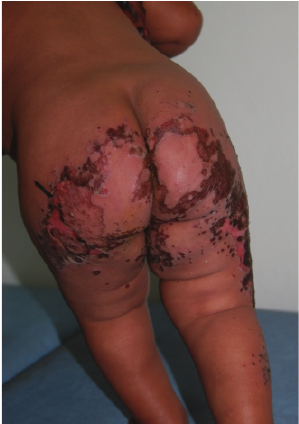
Figure 2: Lesions on buttocks. Marked margins, erosions, and brown